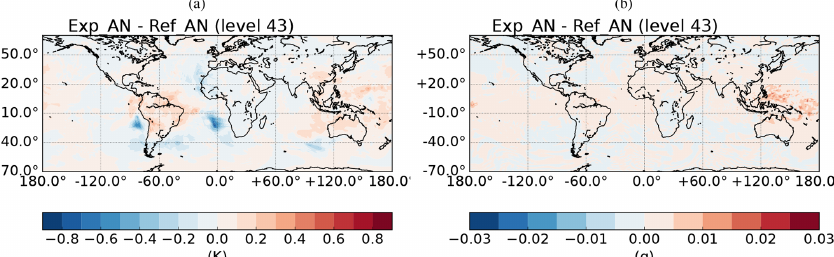
Figure 7. Temperature (a) and humidity (b) analysis difference between REF and EXP for the first assimilation cycle on 7 December 2017 at 00:00UTC at ARPEGE model level 43, which corresponds to 200hPa.